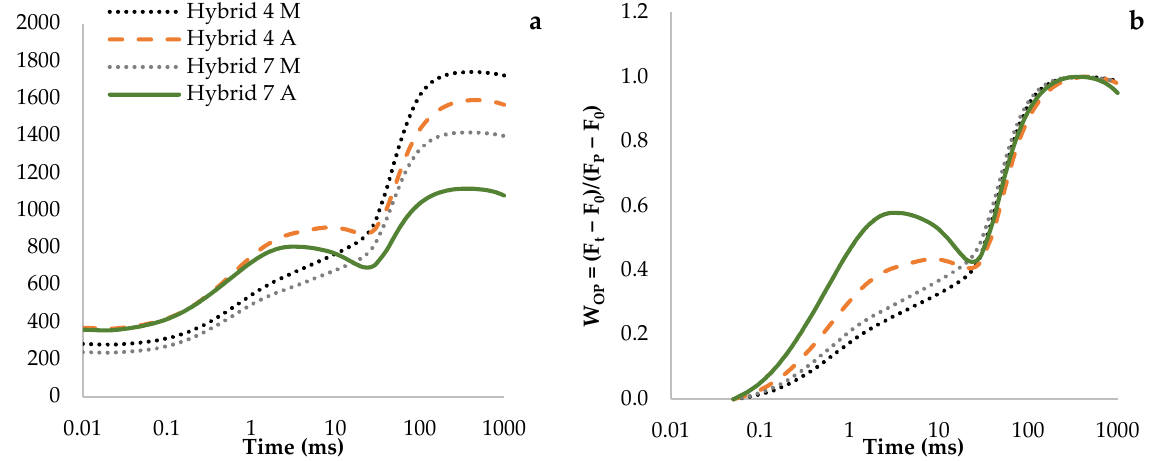
Figure 1. ( a ) Raw fluorescence induction curves, and ( b ) double O–P normalised OJIP curves of chlorophyll a fluorescence kinetics of dark-adapted leaves of sunflower hybrids 4 and 7 under the morning (M) and afternoon (A) conditions. Steps O, J, I, and P are marked in both plots (raw and normalised transients). W OP = (F t − F 0 )/(F P − F 0 ) represents normalised OJIP transient data between Steps O and P. Each curve represents the average kinetics of 12 replicates per condition.